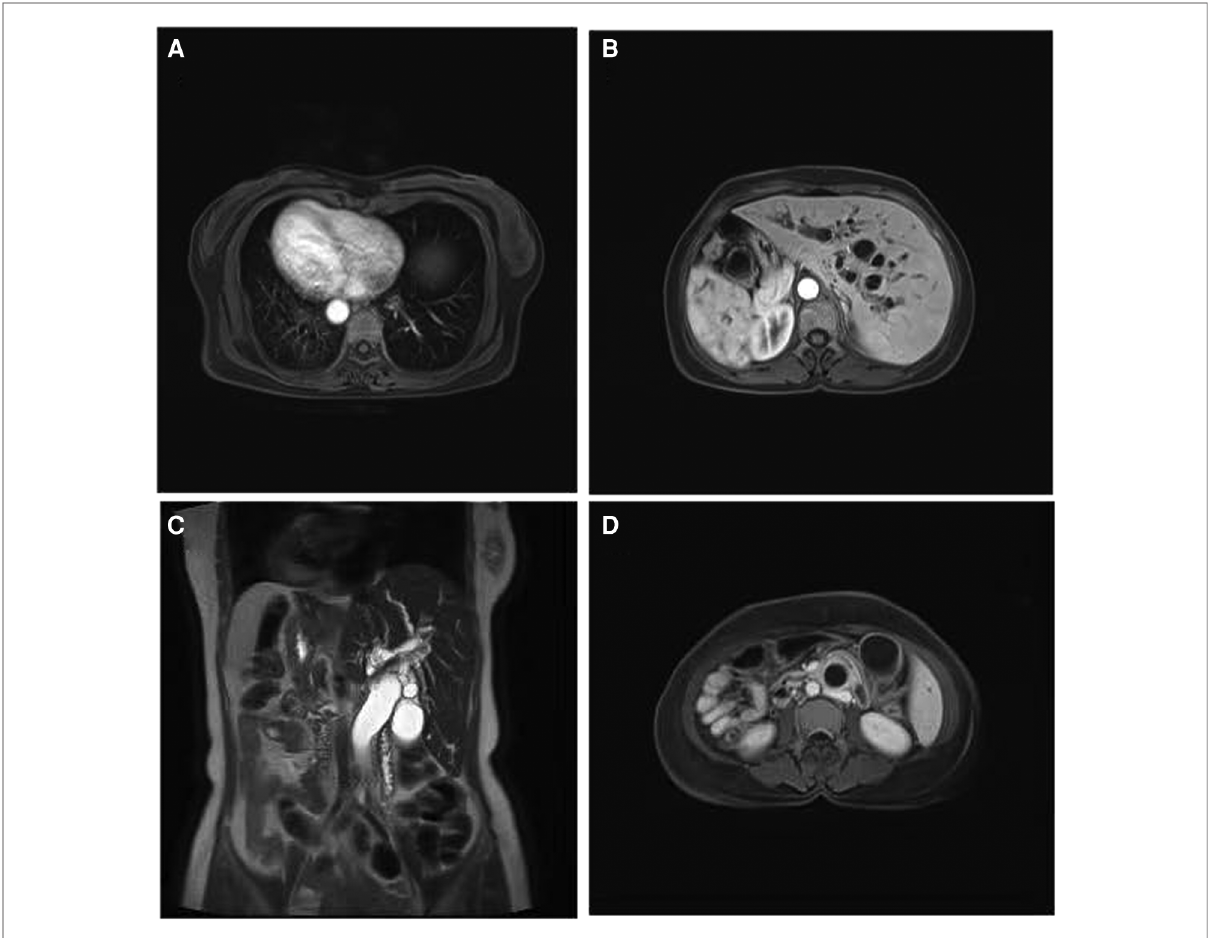
FIGURE 1 Abdomen MRI fi ndings of the female with situs Inversus totalis. ( A ) Inversus of heart; ( B ) inversus of abdominal viscera ( C ) vine-tree-like dilatation of the bile ducts; ( D ) thickening wall of the CBD. MRI, magnetic resonance imaging; CBD, common bile duct.